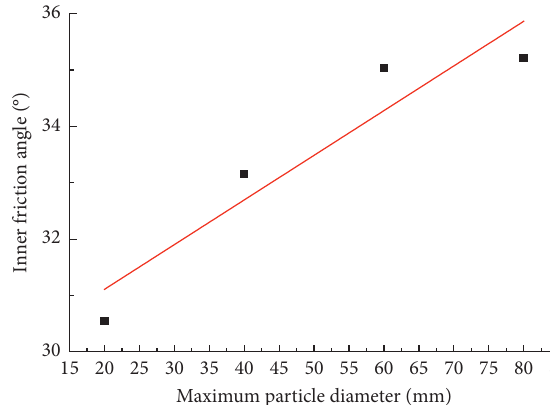
Figure 8: Relationship between inner friction angle and maximum particle